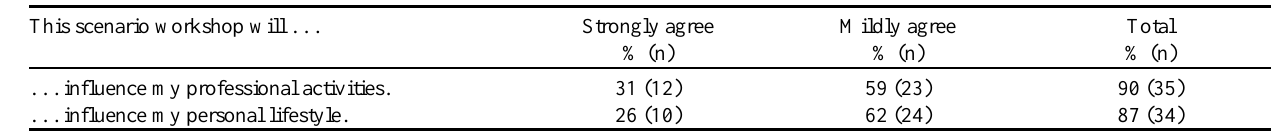
Table 3 . New or changed actions. Percentage of participants who 'strongly agree' (5 on 1 to 5 scale) and 'mildly agree' (4 on 1 to 5 scale) with the following survey statements (n = 39 surveys), and the total number who agree (either 4 or 5 on 1 to 5 scale). This scenario workshop will . .